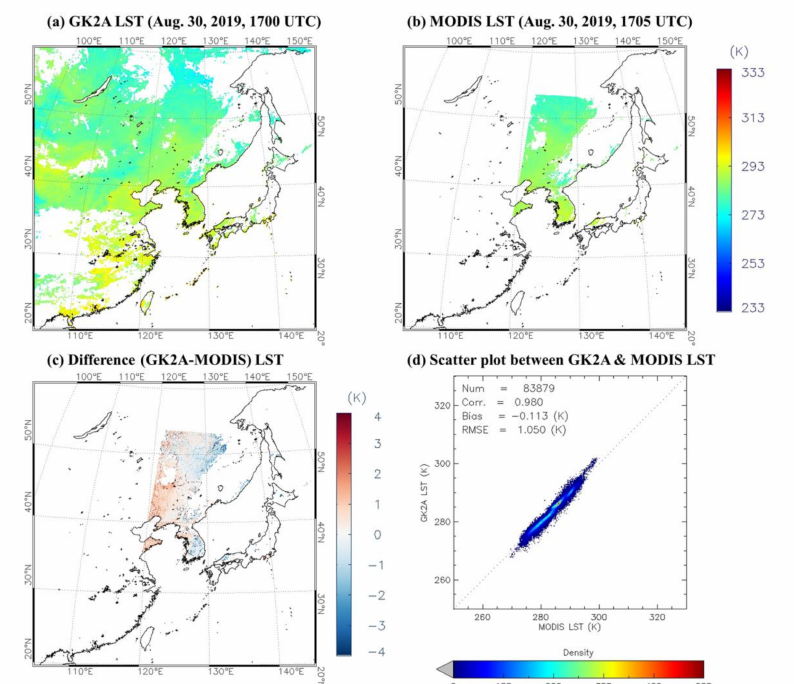
Figure 7. Spatial distribution of ( a ) GK2A LST, ( b ) MODIS (MYD11_L2) LST, ( c ) di ff erences between GK2A and MODIS LSTs, and ( d ) scatter plot between GK2A and MODIS (MYD11_L2) LSTs for 30 August 2019, 1700 and 1705 UTC (gray dotted line in ( d ) represents the 1:1 line).